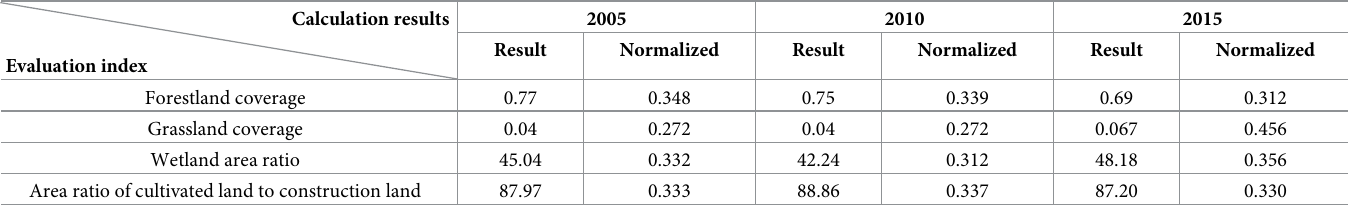
Table 6. Ecological structure index and ecological stress index